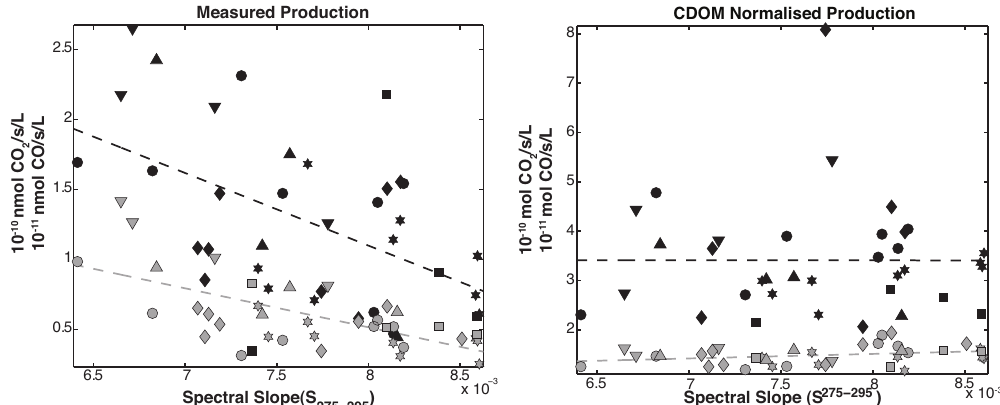
Fig. 6. Measured production and CDOM normalized production with respect to the spectral slope coefficient (275–295nm). Black symbols represent CO 2 ( R 2 = 0 . 26 measured, 1 × 10 − 6 normalized) and grey symbols represent CO ( R 2 = 0 . 44 measured, 0.09 normalized). Symbol